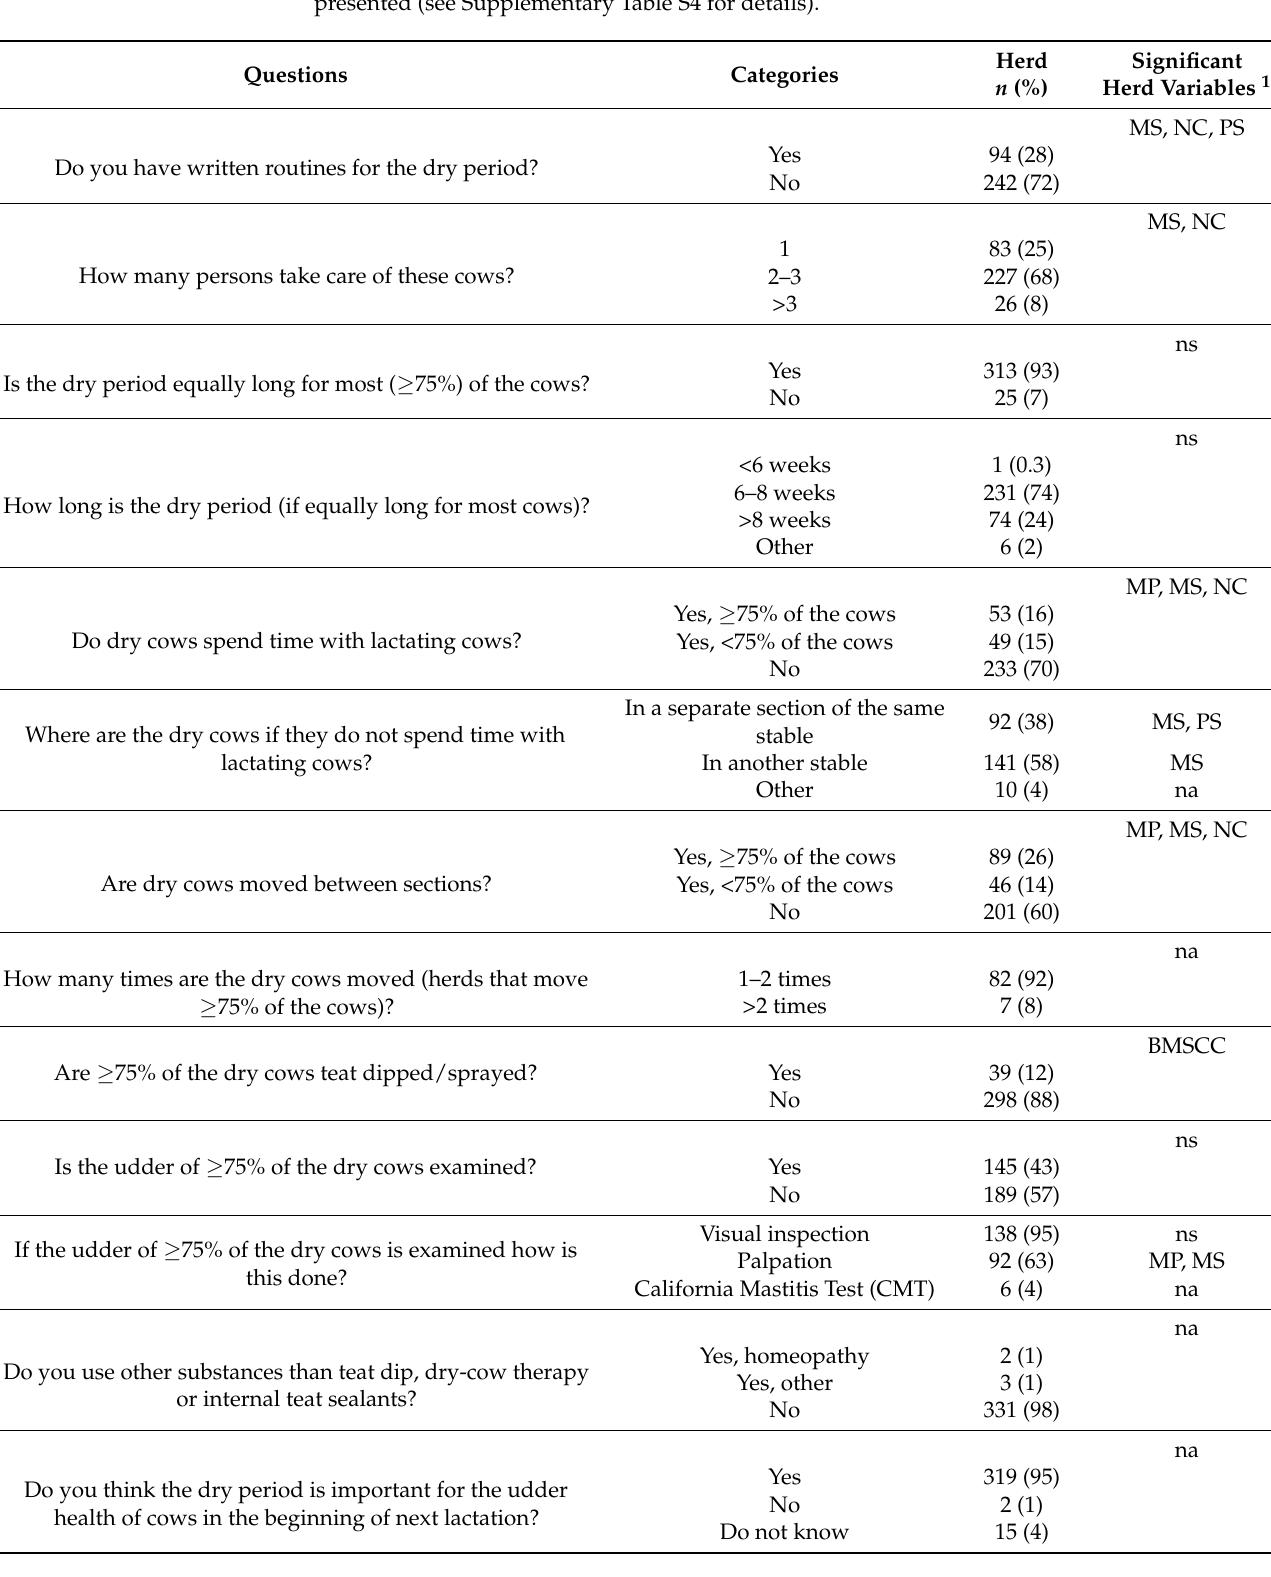
Table 3. Answers to questions about routines during the dry period of dairy cows given by farmers ( n = 340) responding to a web-based questionnaire. Associations between herd variables and answers were investigated by univariable regression models. If significant ( p ≤ 0.05) the herd variables are presented (see Supplementary Table S4 for